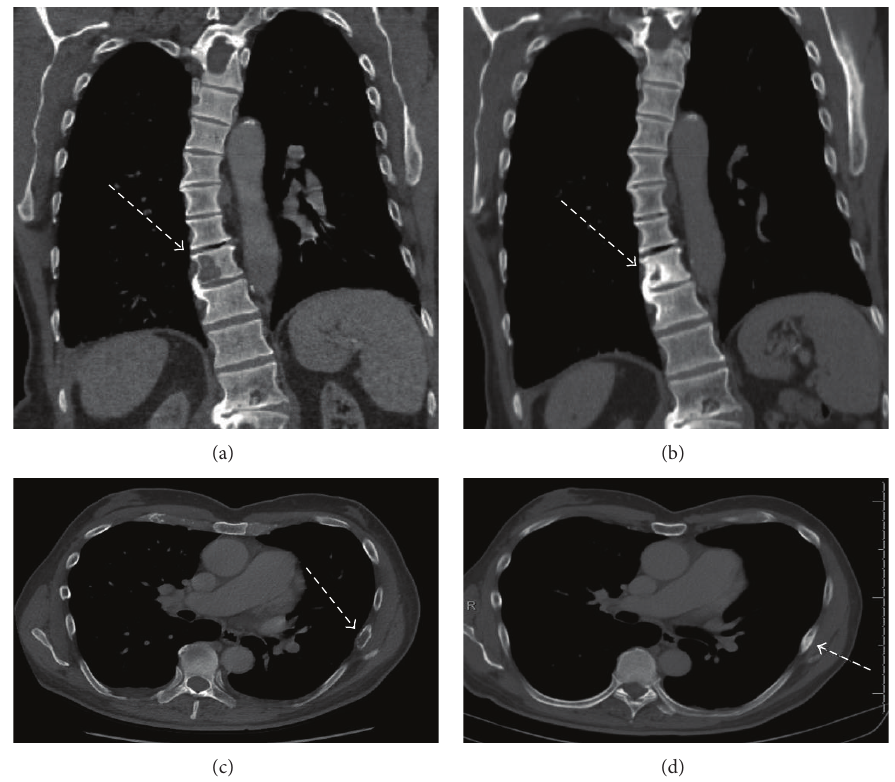
Figure 4: (a) Pretherapy T10 vertebral body lytic metastasis, (b) posttherapy T10 vertebral body becoming sclerotic, (c) pretherapy left 7th rib lytic metastasis, and (d) posttherapy left 7th rib met becoming